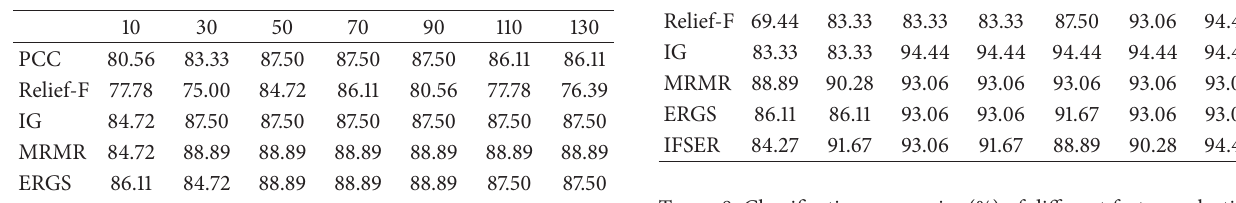
Table 3: Classification accuracies (%) of different feature selection methods with C4.5 on Leukemia2 database.